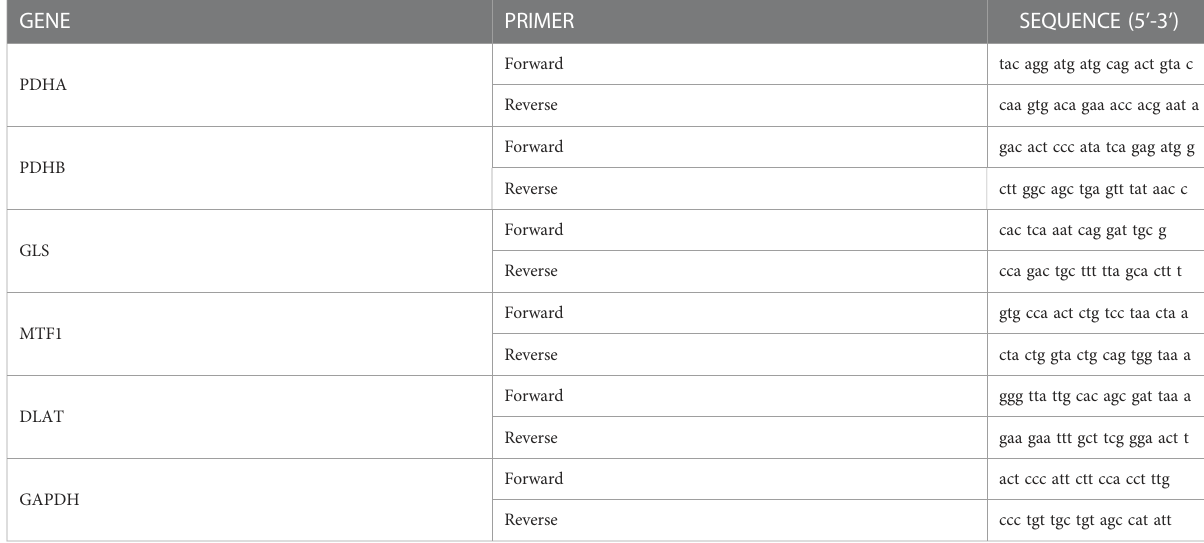
TABLE 1 Primers used qRT-PCR detection.